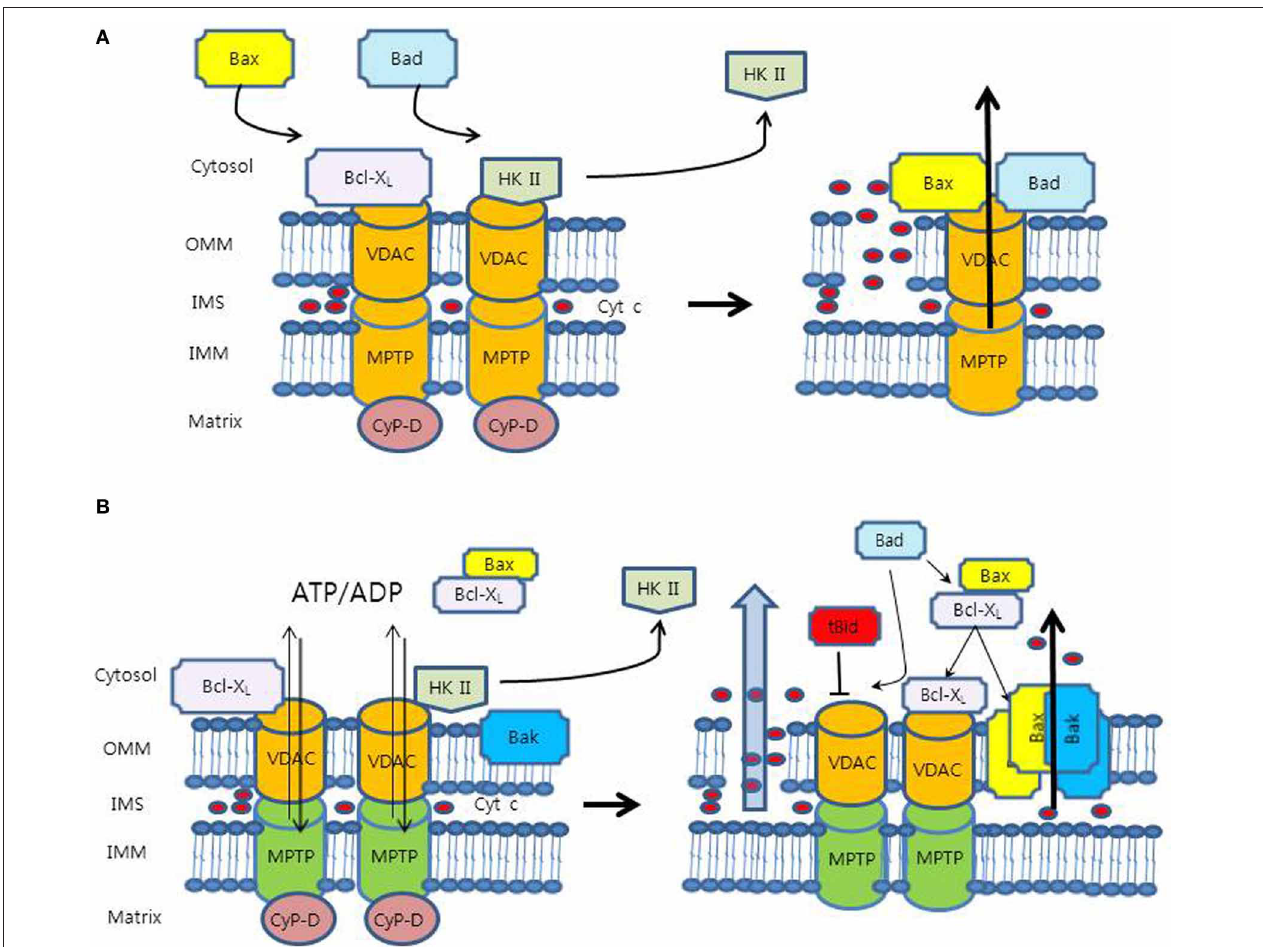
FIGURE 1 | Proposed models for mechanism of the mitochondrial outer membrane permeabilization (MOMP). (A) VDAC is the OMM component of the MPTP complex. In this model, pro-apoptotic proteins (Bax and Bad) interact with VDAC to accelerate its opening, whereas Bcl-X L binds to VDAC directly to close it. VDAC can cause cyt c release indirectly through the swelling and rupture of the OMM. However, this model has problems of relatively small pore size and dispensability of VDAC. (B) In an anti-apoptotic state, anti-apoptotic molecules (HK II and Bcl-X L ) bind to VDAC and keep it in open configuration with low-conductance for the exchange of adenine